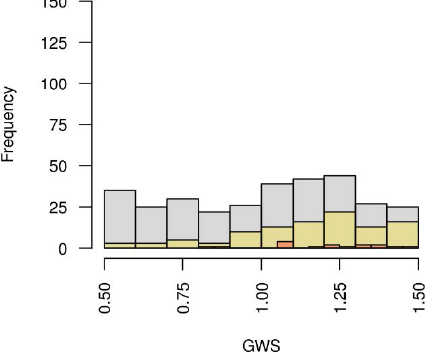
Figure 14. Land-to-ocean bicarbonate flux scaling factor (GWS)